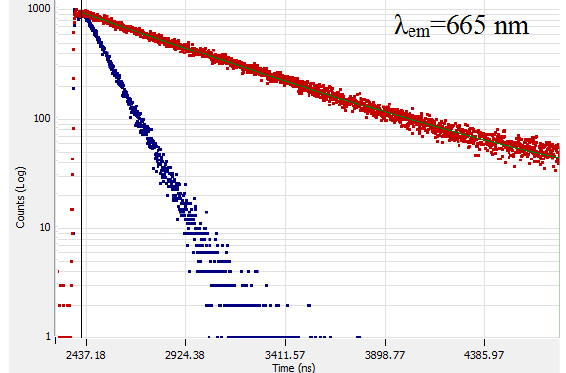
Figure 4. Kinetic decay curves (red curves) of UCL recorded at 545 nm and 665 nm under excitation with wavelengths of 980 nm (concentration of Tm 3+ was of 28 at.%) at T = 80 K. Blue curves—excitation source pulse.